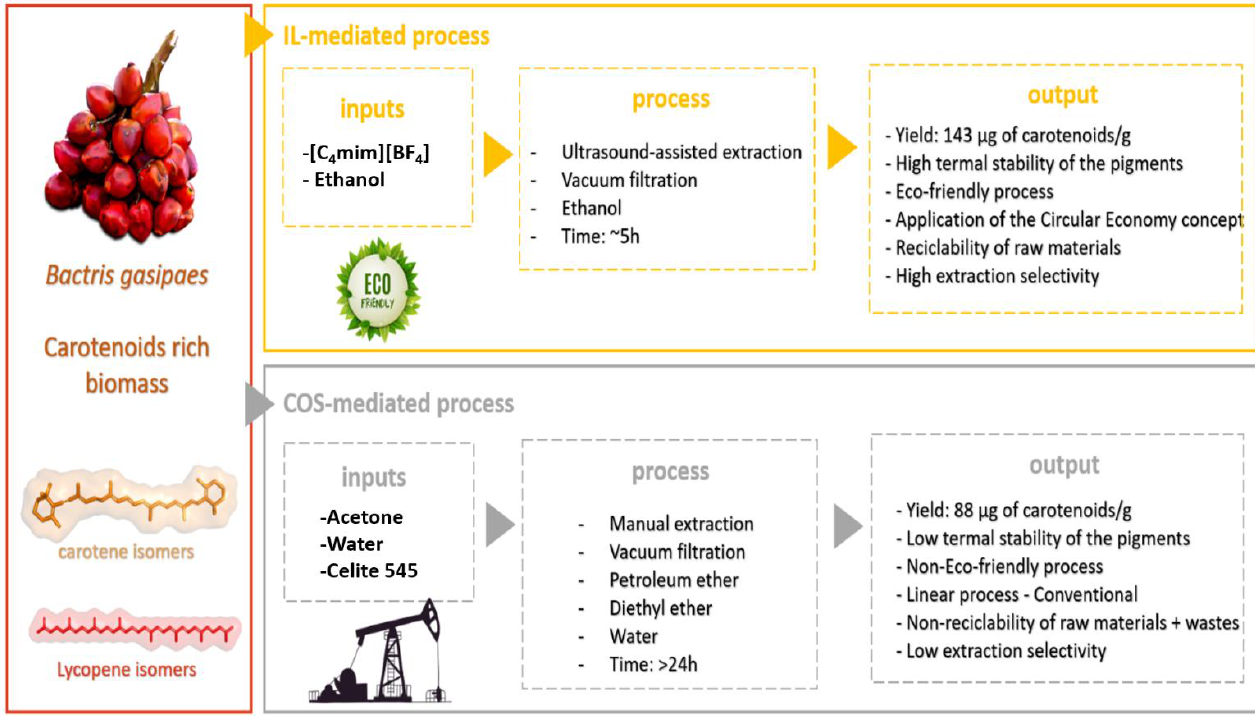
Figure 1. Schematic representation of the extraction processes evaluated in this study. The IL-mediated process is considered an eco-friendly method; and the COS-mediated process, based on organic solvents derived from petroleum.